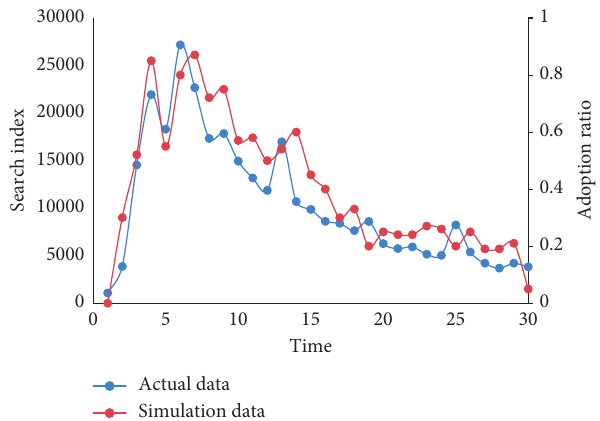
Figure 5: Comparison of simulated environment and real market